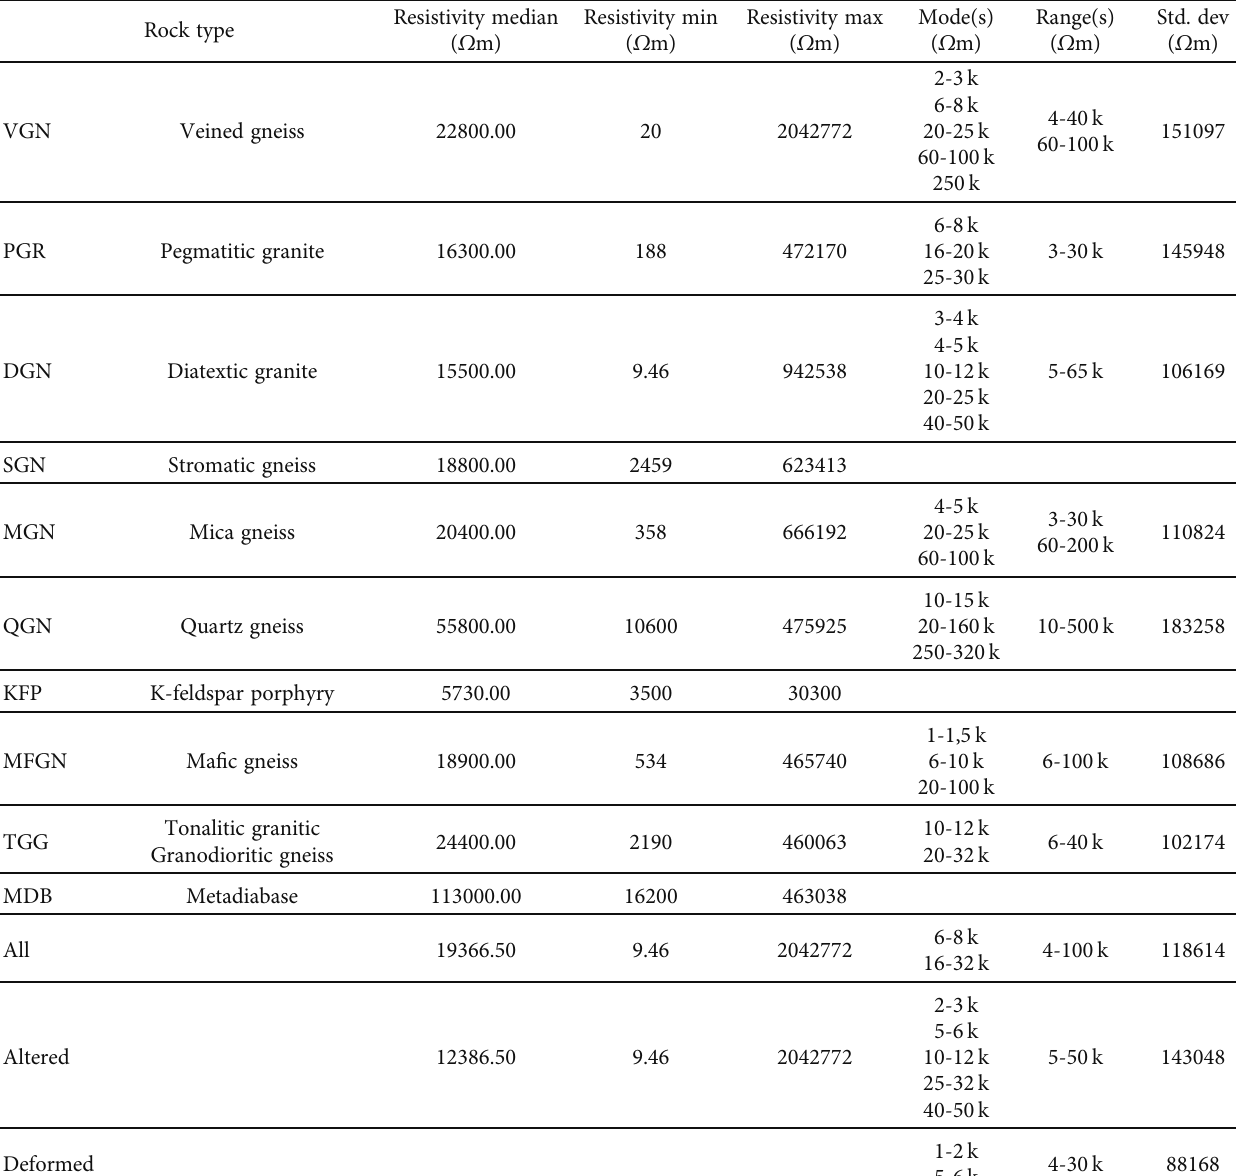
Table 1: Resistivity ranges for the di ff erent rock types